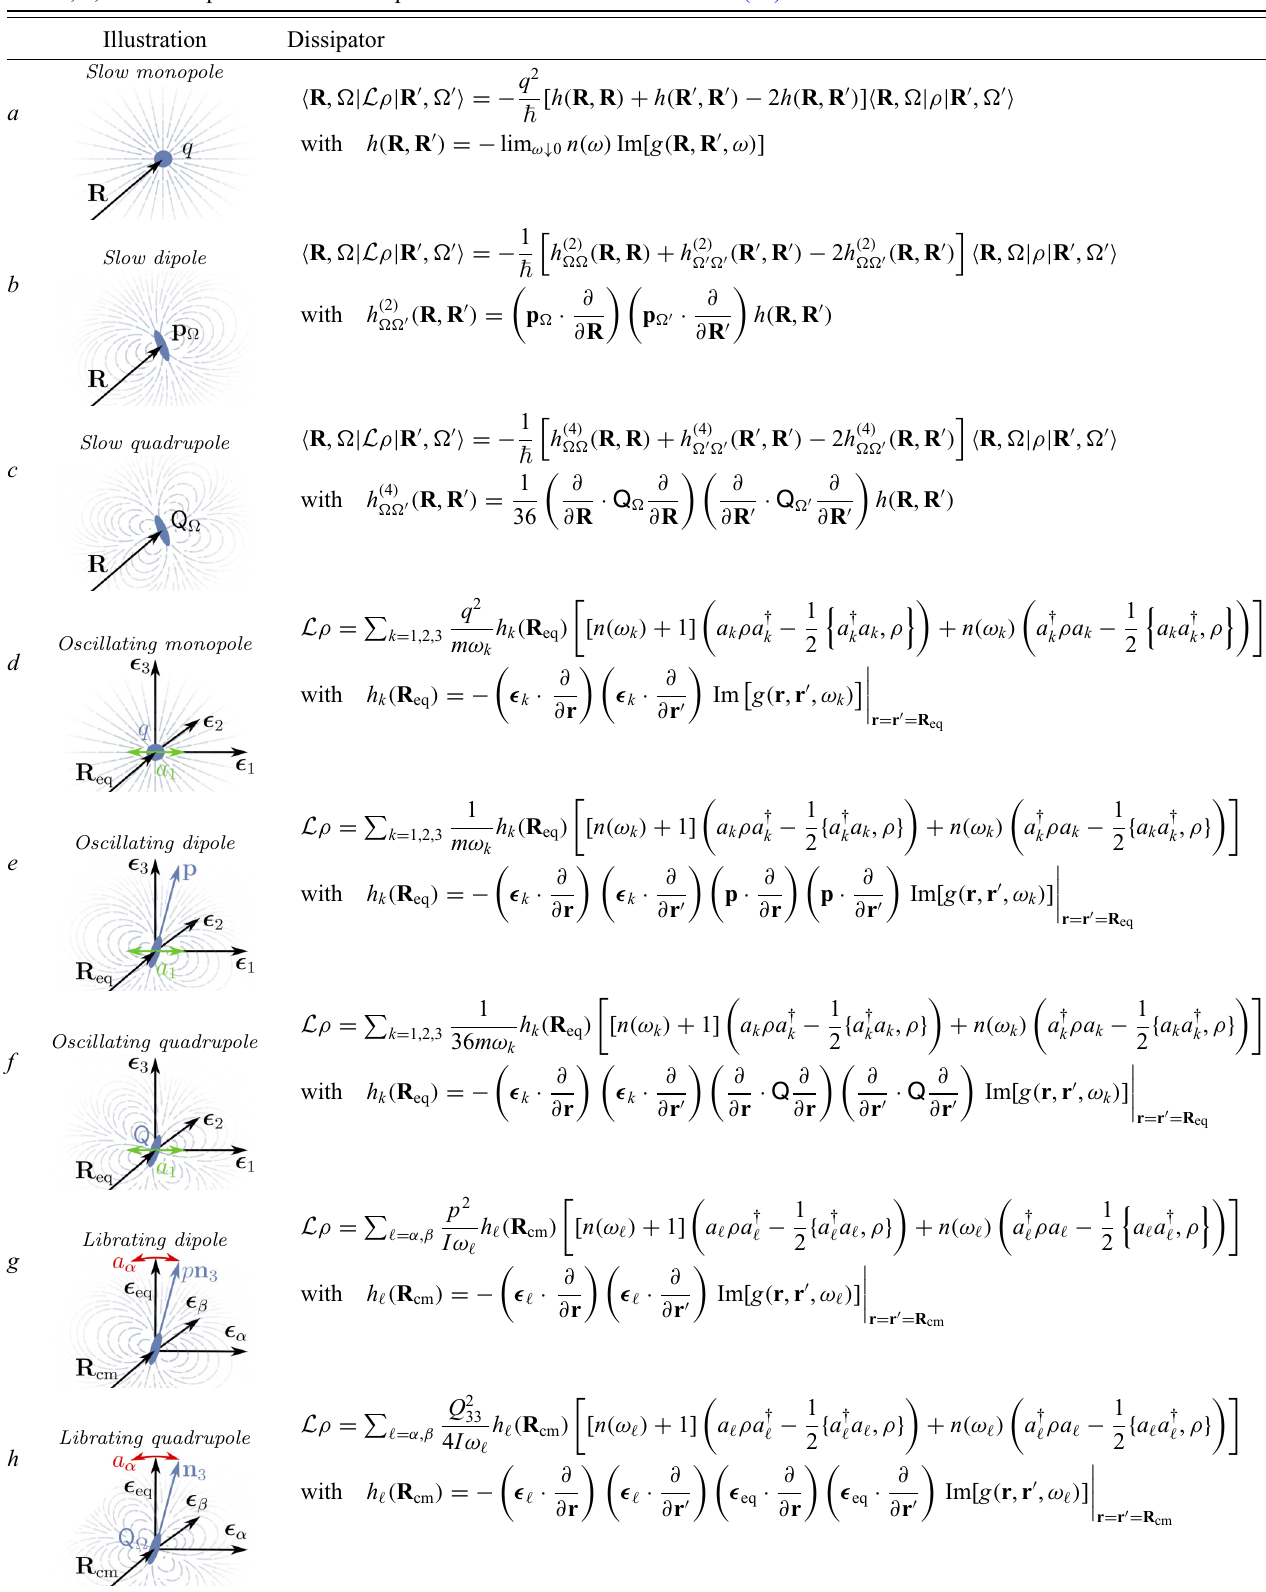
TABLE I. Selection of quantum master equations for typical charge distributions and types of motion; see Sec. III. The prefactors in lines a , b , and c are special cases of the spatio-orientational decoherence rate (18).